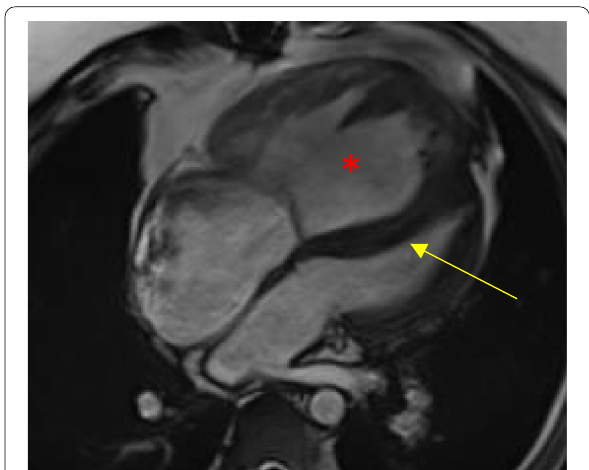
Fig. 10 Four-chamber MRI SSFP cine in a patient post-TOF repair. There is significant right ventricular hypertrophy and dilatation (red asterisk). The interventricular septum is also shifted towards the left ventricle (yellow arrow)